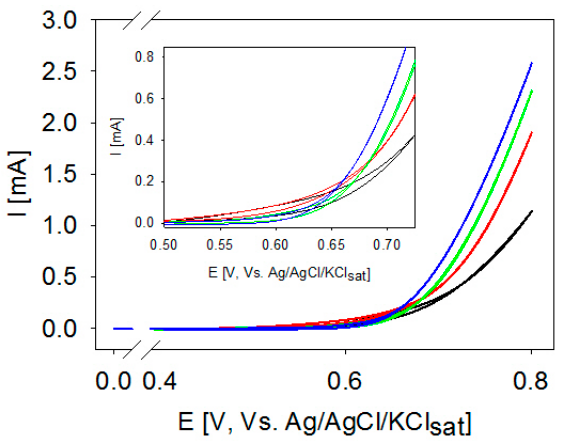
Figure 1. Cyclic voltammetry curves recorded on a steel AISI 316L working electrode (WE). 50 mV / s potential scan rate, Pt sheet as counter (CE) and Ag / AgCl / KCl sat as RE. KOH 0.1 M aqueous solution is the base electrolyte. L-( + )-tartaric acid concentration: ( blue ) 0 mM, ( green ) 0.5 mM, ( red ) 5 mM, ( black ) 25 mM. The inset shows the CV detail in the 0.5 and 0.75 V potential range.